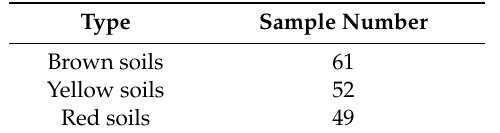
Figure 1. Location map showing the corresponding study area sample locations.